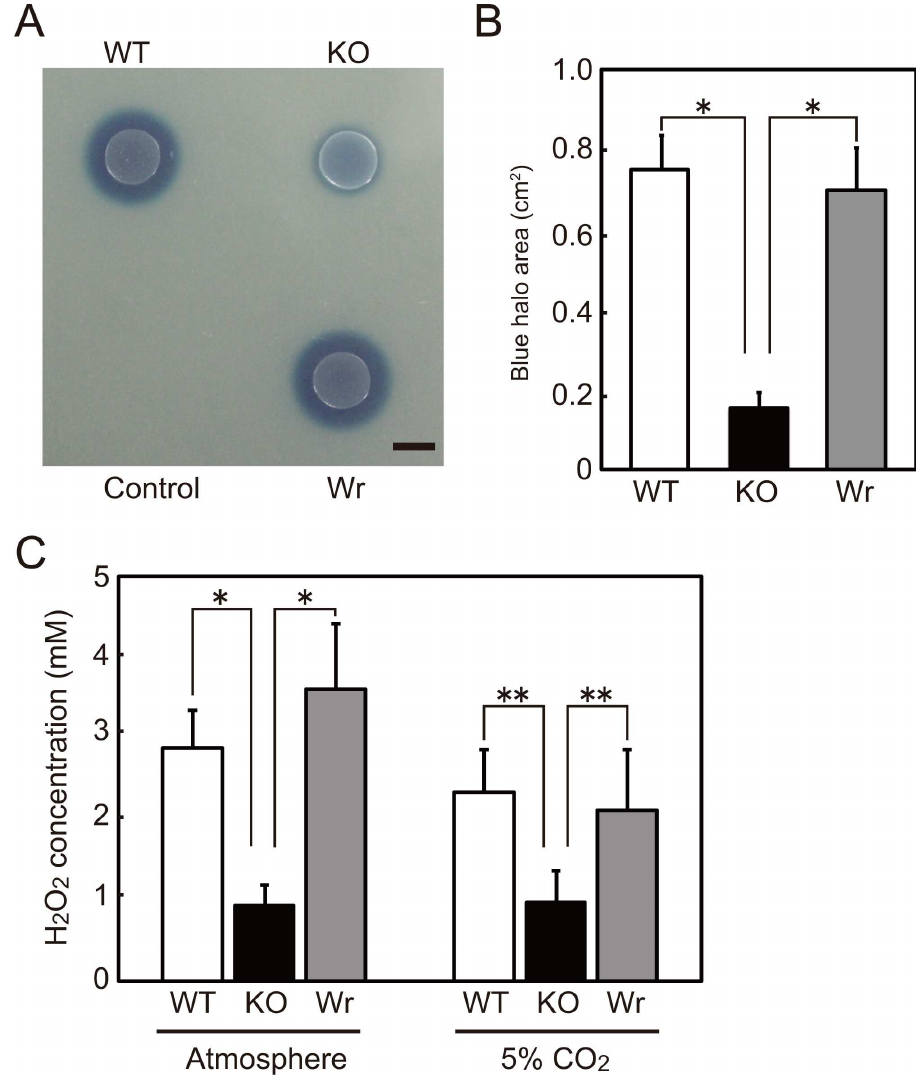
Fig 1. Effect of spxB deletion on H 2 O 2 production by S . sanguinis . (A) H 2 O 2 production by S . sanguinis strains was examinedusing Prussian blue agar plates. Overnight cultureswere spotted on the plates and incubated for 24 h. BHI mediumwas usedas a negativecontrol.Bar, 5 mm. (B) After 24 h of incubation, the area of blue halosaroundcolonieswas determined usingImage J software. Data are shownas the mean ± SD of triplicatesamplesfrom 3 independent experiments. Statistically significantdifferenceswereevaluatedusing one-wayANOVA and Tukey’s multiplecomparison test. * p < 0.01.(C) Concentrations of H 2 O 2 in culture supernatants of S . sanguinis strains grownovernightwerequantifiedusingperoxidasereactions.Data are shownas the mean ± SD from 3 (B) or 4 independent experiments. Statistically significant differences were evaluated usingtwo-wayANOVA andTukey’s multiplecomparison test. * p < 0.01.